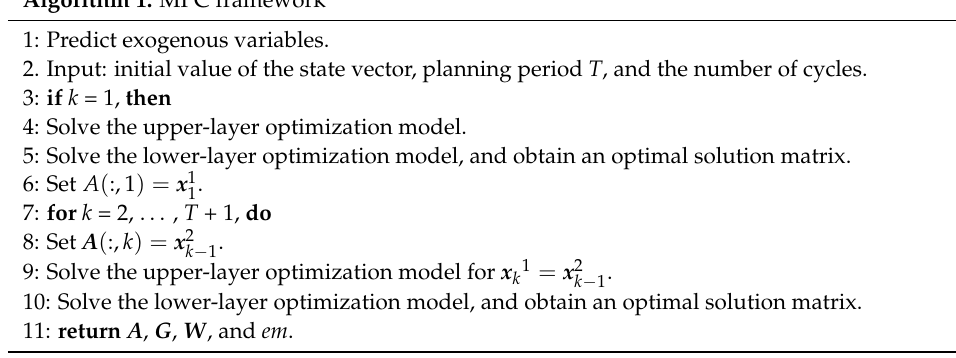
Algorithm 1. MPC